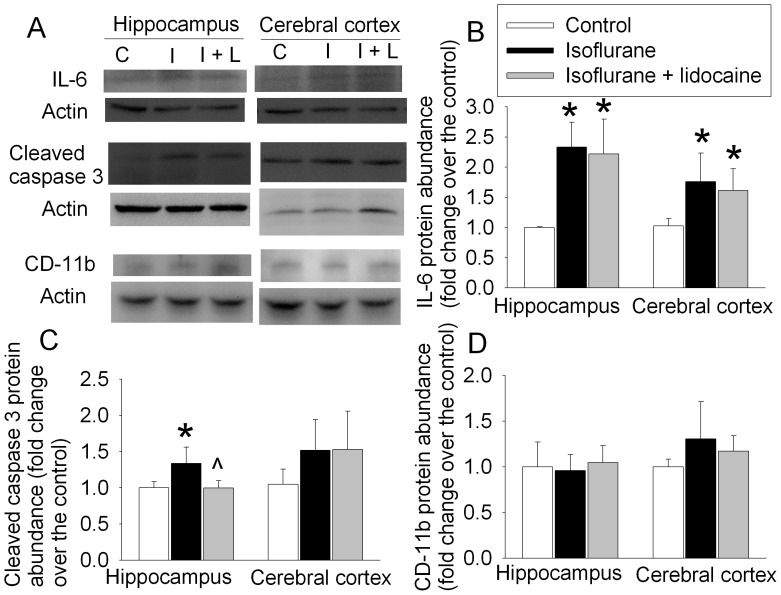
Isoflurane effects on the expression of interleukin 6 (IL-6), activated/cleaved caspase 3 and cluster of differentiation 11b (CD-11b) in rat brain tissues.Eighteen-month-old Fisher 344 rats were exposed to or were not exposed to 1.2% isoflurane in the presence or absence of lidocaine for 2 h. Hippocampus and cerebral cortex were harvested at 6 h after anesthetic exposure for Western blotting. A: representative Western blot images. B, C and D: graphic presentation of the IL-6, cleaved caspase 3 and CD-11b protein abundance quantified by integrating the volume of autoradiograms from 4 rats for each experimental condition. Values in graphs are expressed as fold changes over the mean values of control animals and are presented as the means±S.D. *P<0.05 compared with the control group. ? P<0.05 compared to isoflurane alone. Statistical analysis was performed by one-way analysis of variance. C: control, I: isoflurane, I+L: isoflurane plus lidocaine.